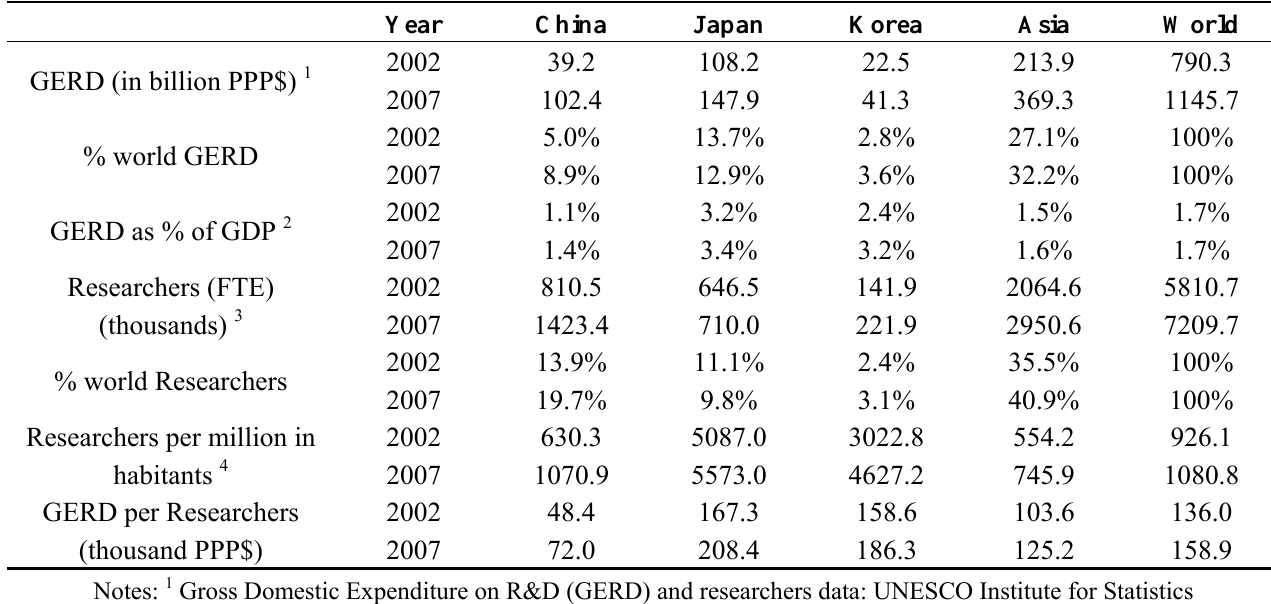
Table 2. R&D Expenditure (GERD) and Researchers in China, Japan and Korea (2002 and 2007) [35].